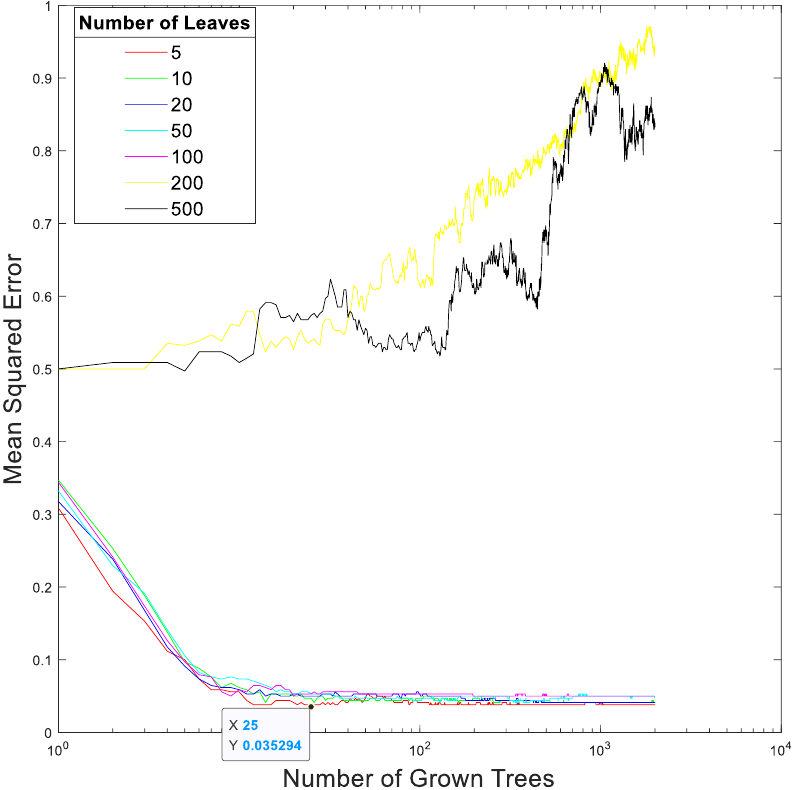
Figure 16. The relationship between the mean squares error and the total number of trees at different total numbers of leaf nodes in the random forest in our proposed method trained using the EEGs acquired from Hejian performing the reading activity under the concentration state on the second day.